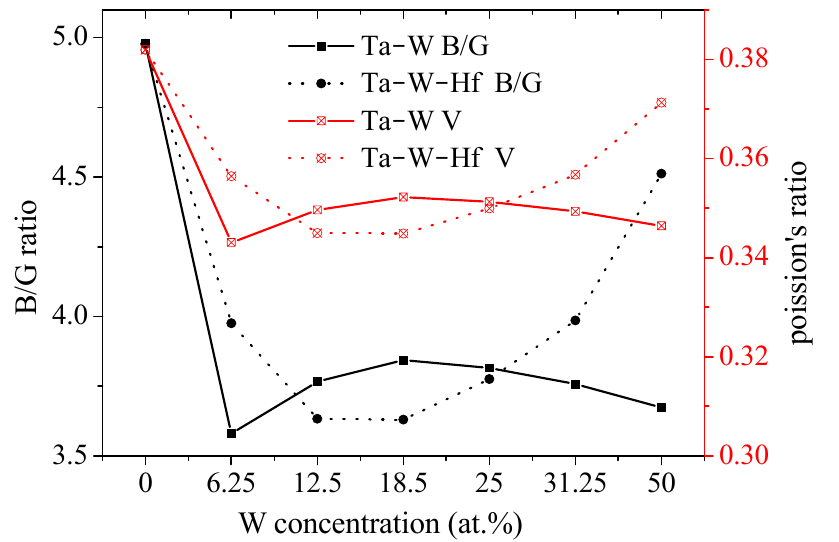
Figure 7. The B/G and Poisson’s ratio value of Ta–W and Ta–W–Hf alloys with different W